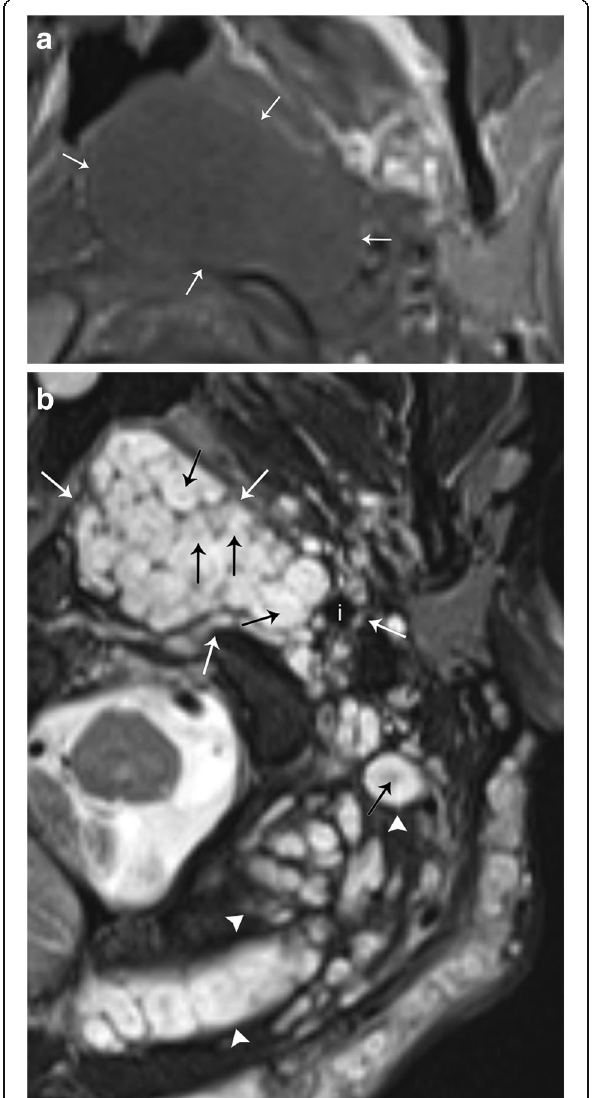
Fig. 7 Plexiform neurofibroma. a Axial T1-weighted MR image demonstrates a mass that is iso − /hypointense to muscle (arrows). b Axial T2-weighted MR image demonstrates numerous hyperintense masses involving the left carotid space (white arrows). The left internal carotid artery (i) is displaced posterolaterally. Note the characteristic “ fish-eye ” or “ target ” appearance of this lesion (black arrows). This patient had neurofibromatosis, and extensive trans- spatial neurofibromas can be seen in other portions of the neck (arrowheads)